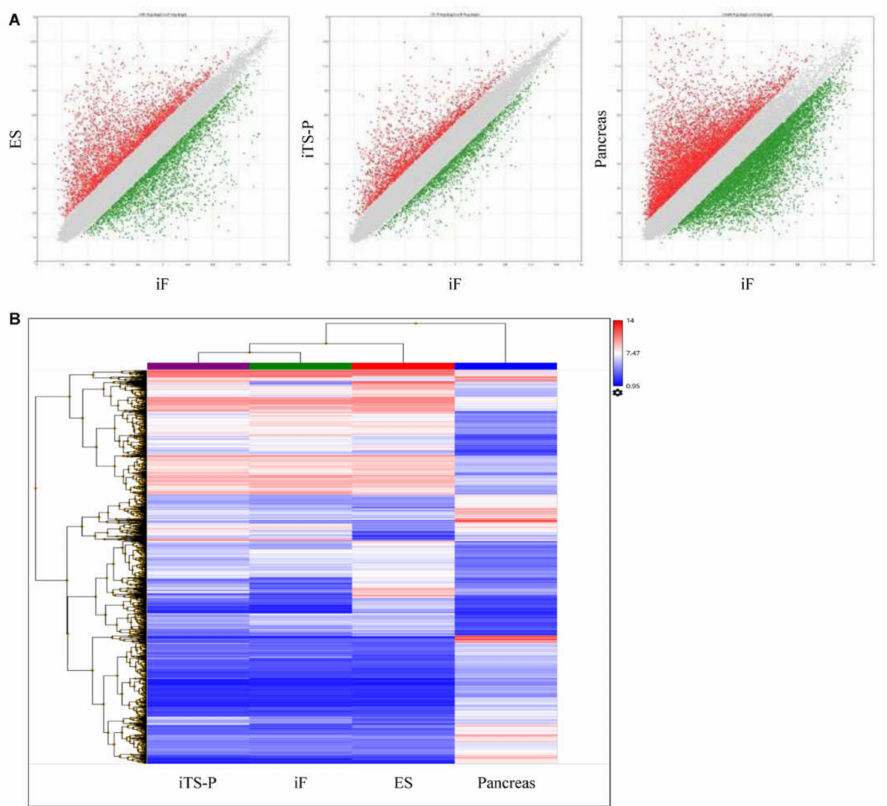
Figure 2. Microarray analysis. ( A ) Global gene expression patterns were compared between iF cells and ES cells, iTS-P cells, or pancreatic tissue cells (>95% islets) using a Transcriptome Analysis Console (Affymetrix). The gray area indicates genes expressed at levels differing by <2-fold between the two samples. ( B ) Unsupervised hierarchical clustering of gene expression profiles of iF cells, iTS-P cells, ES cells, and pancreatic tissue cells (>95% islets). Each column represents one biological